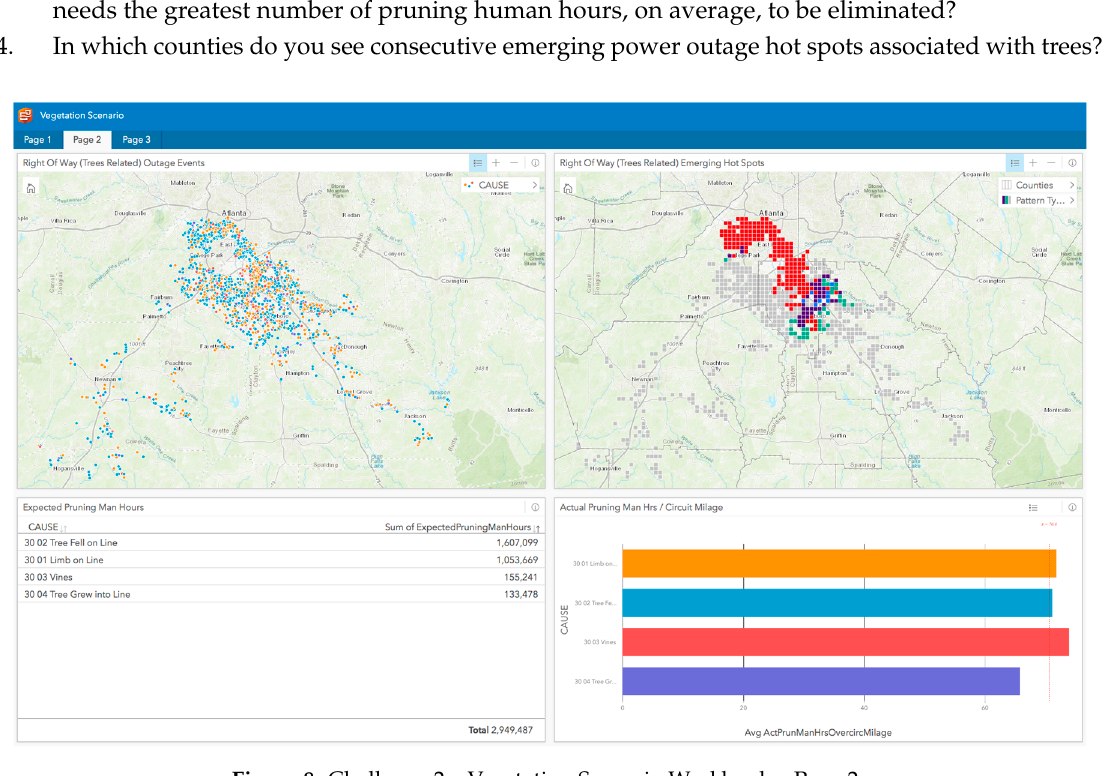
Figure 8. Challenge 2—Vegetation Scenario Workbook—Page 2.